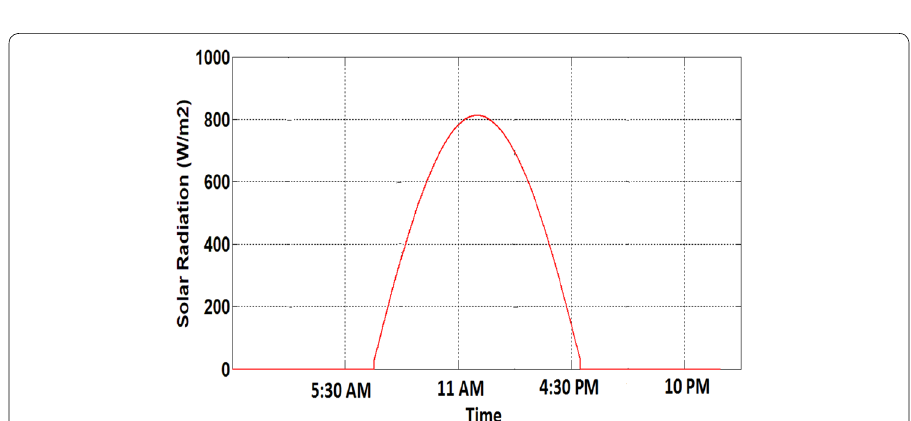
Fig. 9 Variation in solar radiation for Case